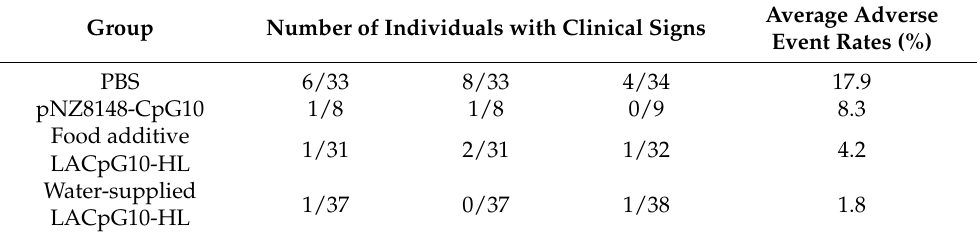
Table 1. Adverse event rates under normal farming conditions.